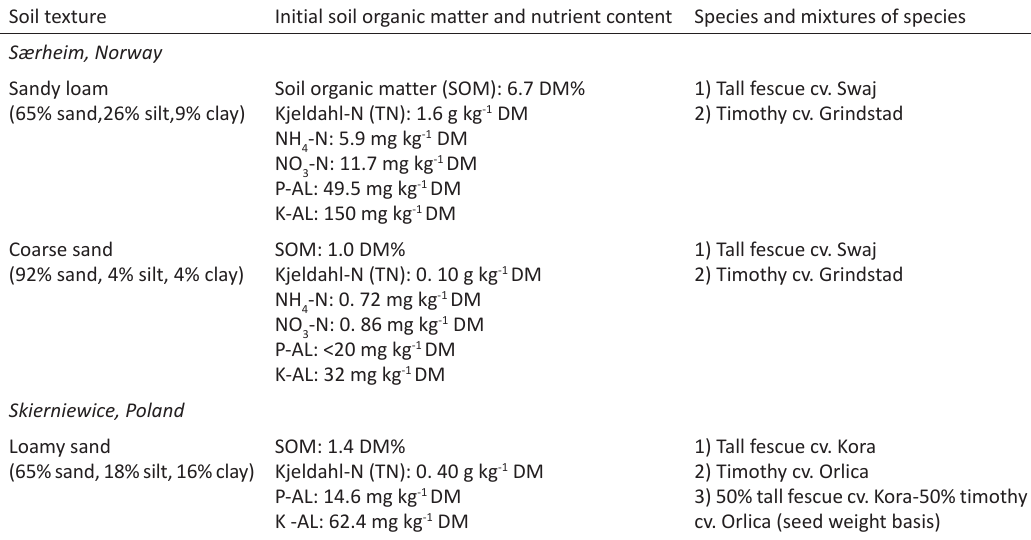
-N), nitrate-N (NO -N) and plant-available phosphorus 4 3